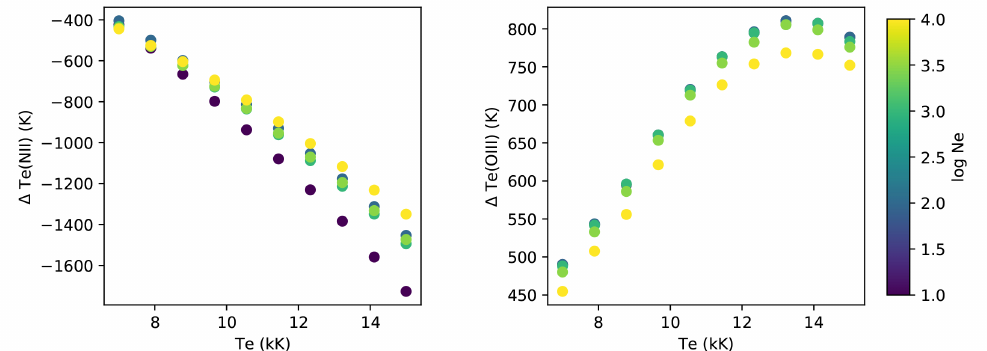
Figure 8. Temperature differences caused by using the MBZ20 ECS relative to the PyNeb defaults. Left panel: T e (N II ). Right panel: T e (O III